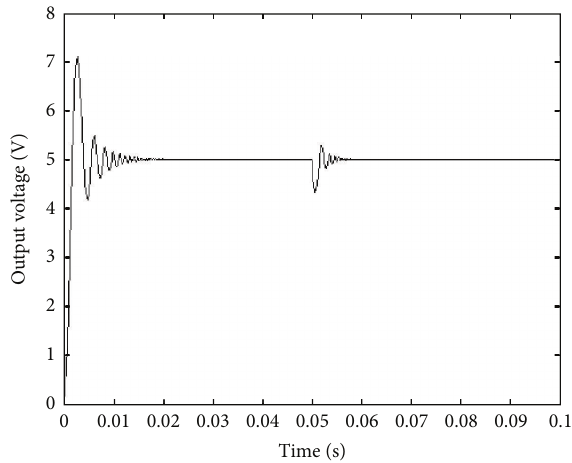
Figure 10: The DC/DC output voltage for step load variation in direct control